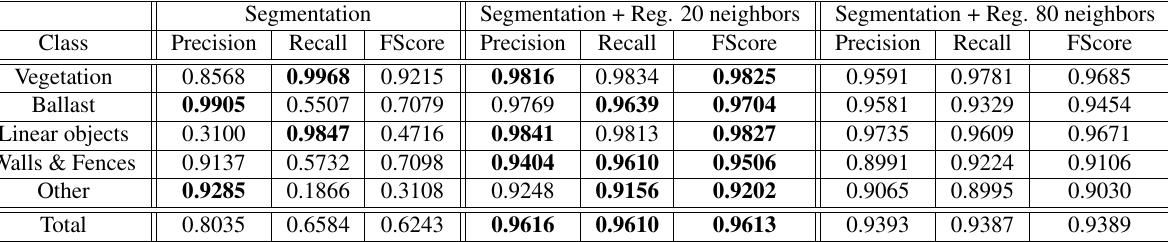
Table 1. Detailed results when no pre-segmentation has been done.